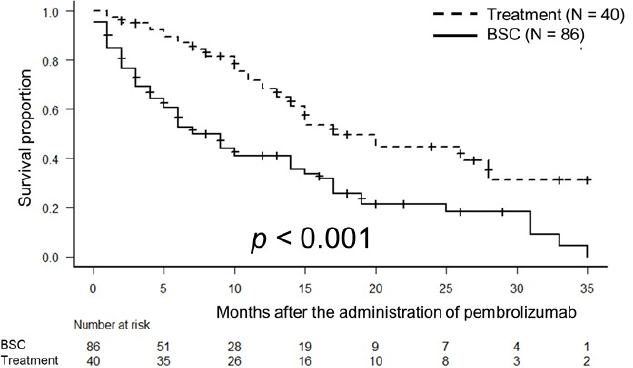
Figure 1. Kaplan–Meier estimates of overall survival (OS) in patients with metastatic urothelial carcinoma who received third-line therapy (treatment group) and those who did not receive third-line therapy (BSC group). The median OS times were 17 months in the treatment group and 9 months in the BSC group ( p < 0.001).